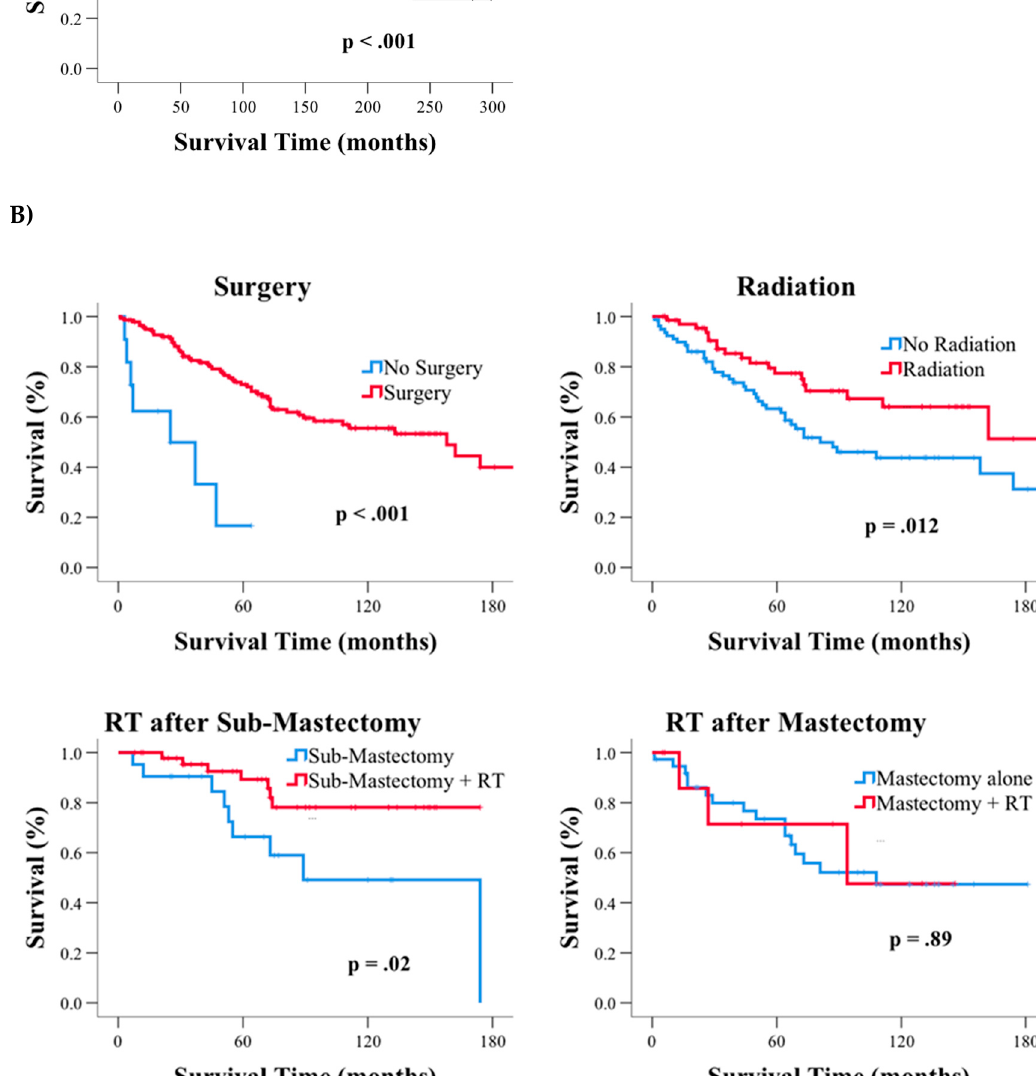
Figure 2. Kaplan-Meier curves for glycogen-rich clear cell (GRCC) based on ( A ) clinical factors and ( B ) treatment. AJCC—American Joint Committee on Cancer; T, N, M refers to tumor size, nodal status, and metastasis classifications of malignant tumor staging system, respectively; RT—radiation therapy. 201